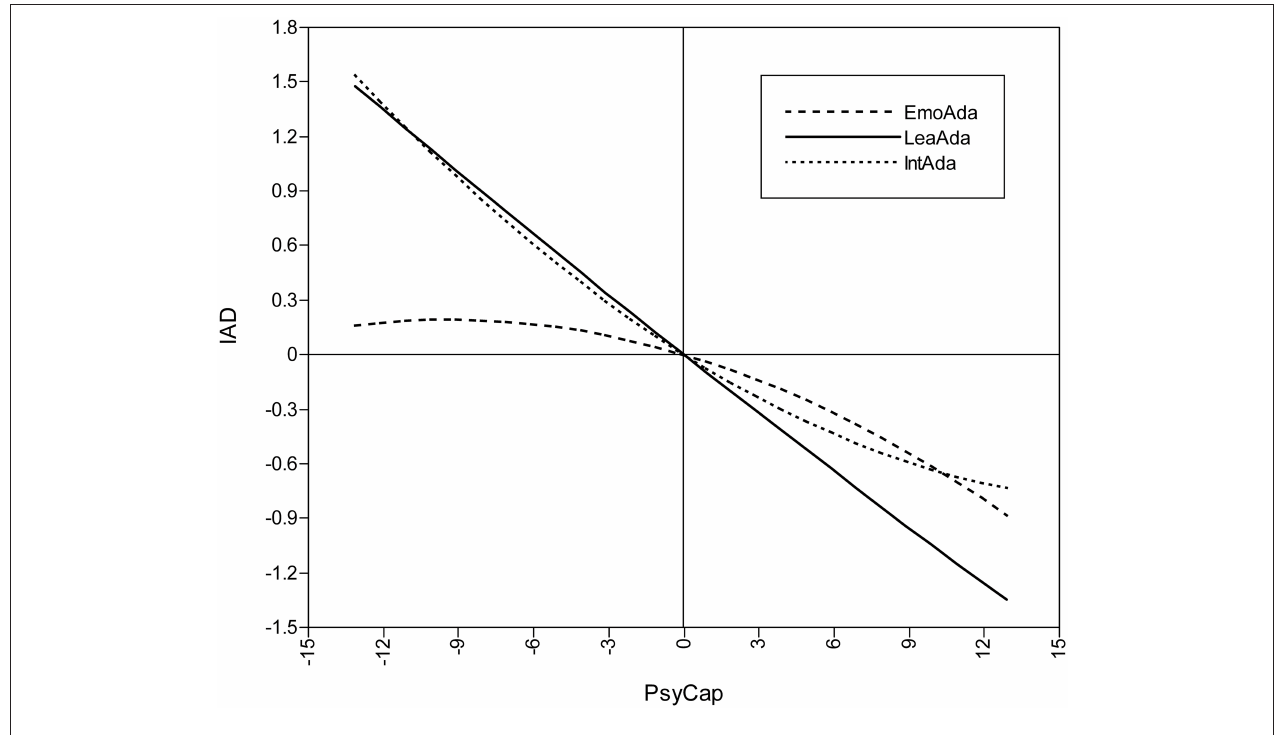
FIGURE 2 | Moderated mediation effect of PsyCap on IA.